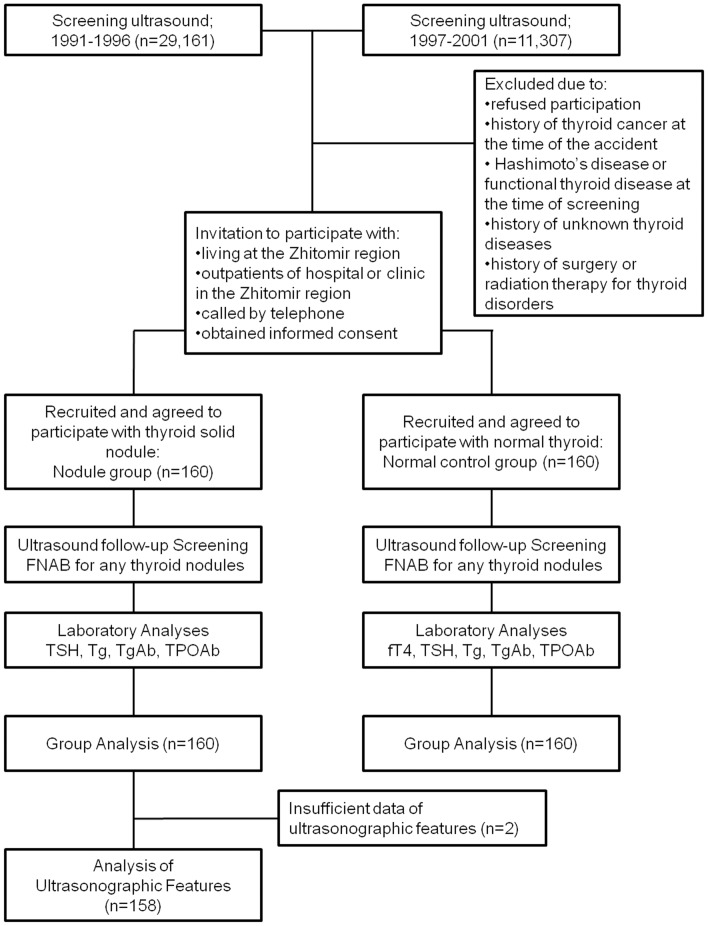
Flow chart of the study selection process and study method.